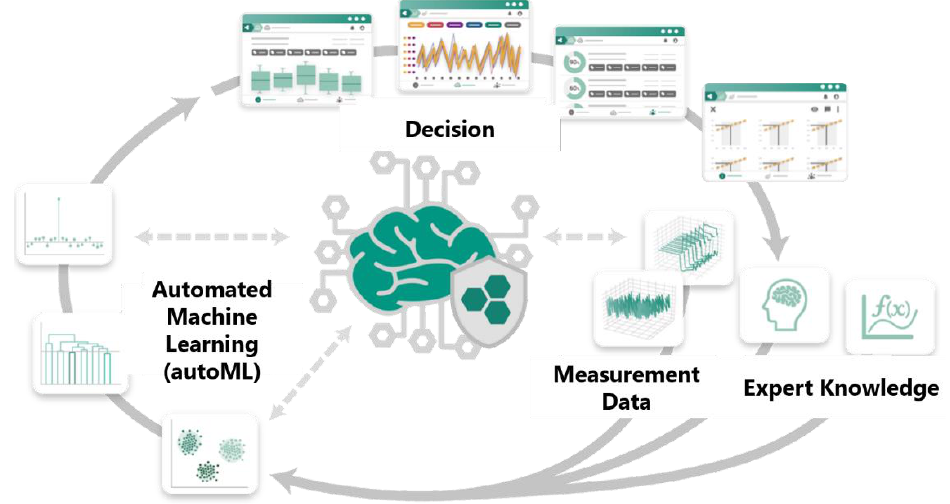
Figure 1. Procedure of continuous learning in the artificial intelligence (AI)-based hybrid model. Along with a cloud-based IT solution from Engineering Data Intelligence (EDI Ltd.,